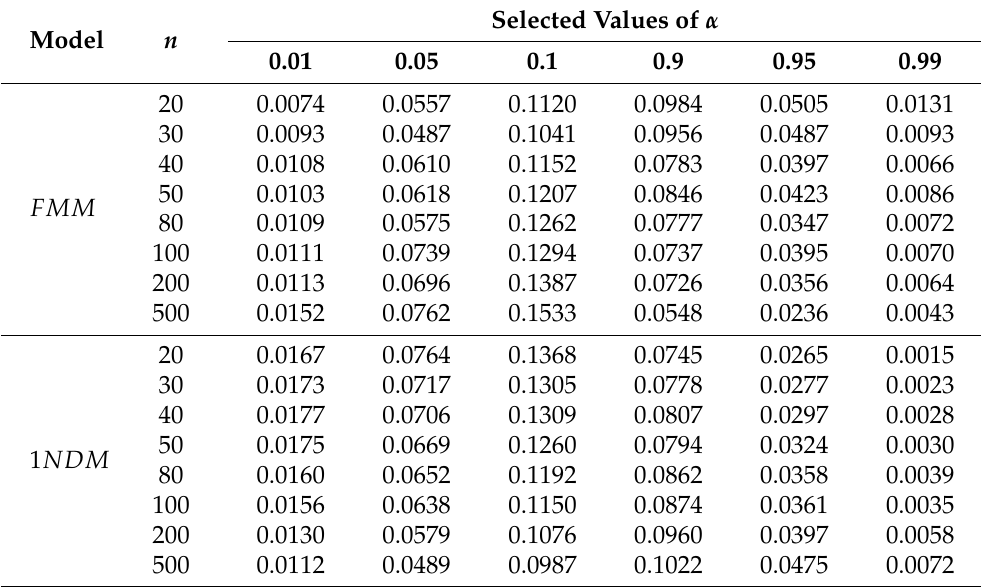
Table 9. EMAS test: proportion of times where the null hypothesis is rejected (mean case) when using the FMM and the 1NDM (based on 5000 simulations).